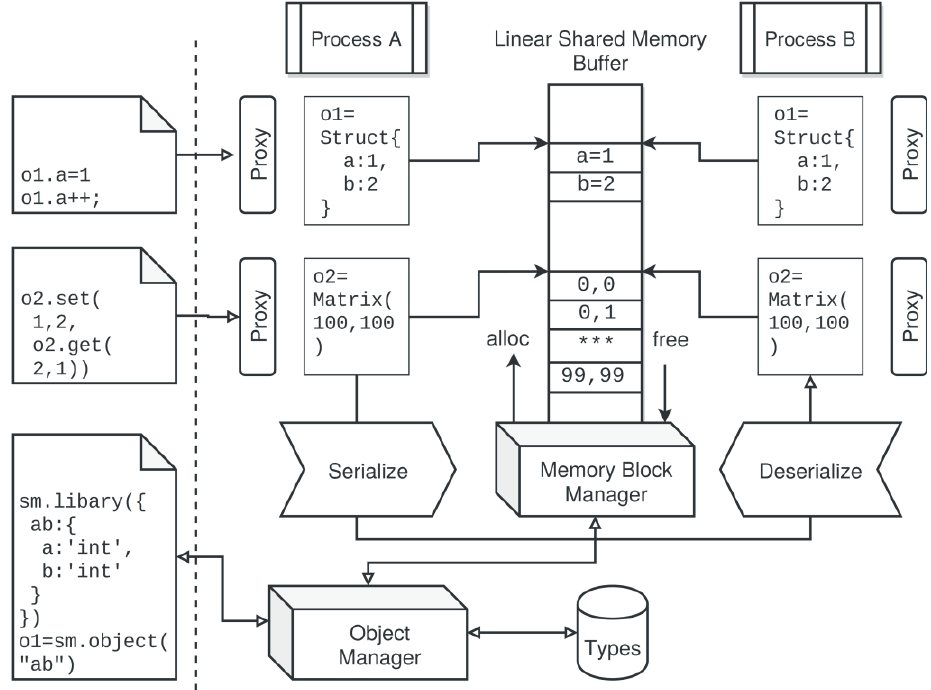
Figure 6. Shared buffer objects: architecture and programmatical access.